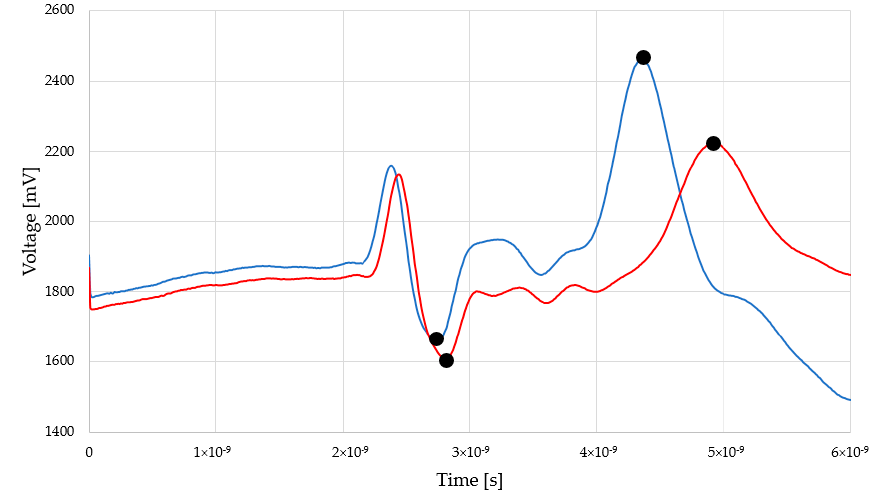
Figure 4. Reflectograms achieved by Sensor A for dry and moist material.